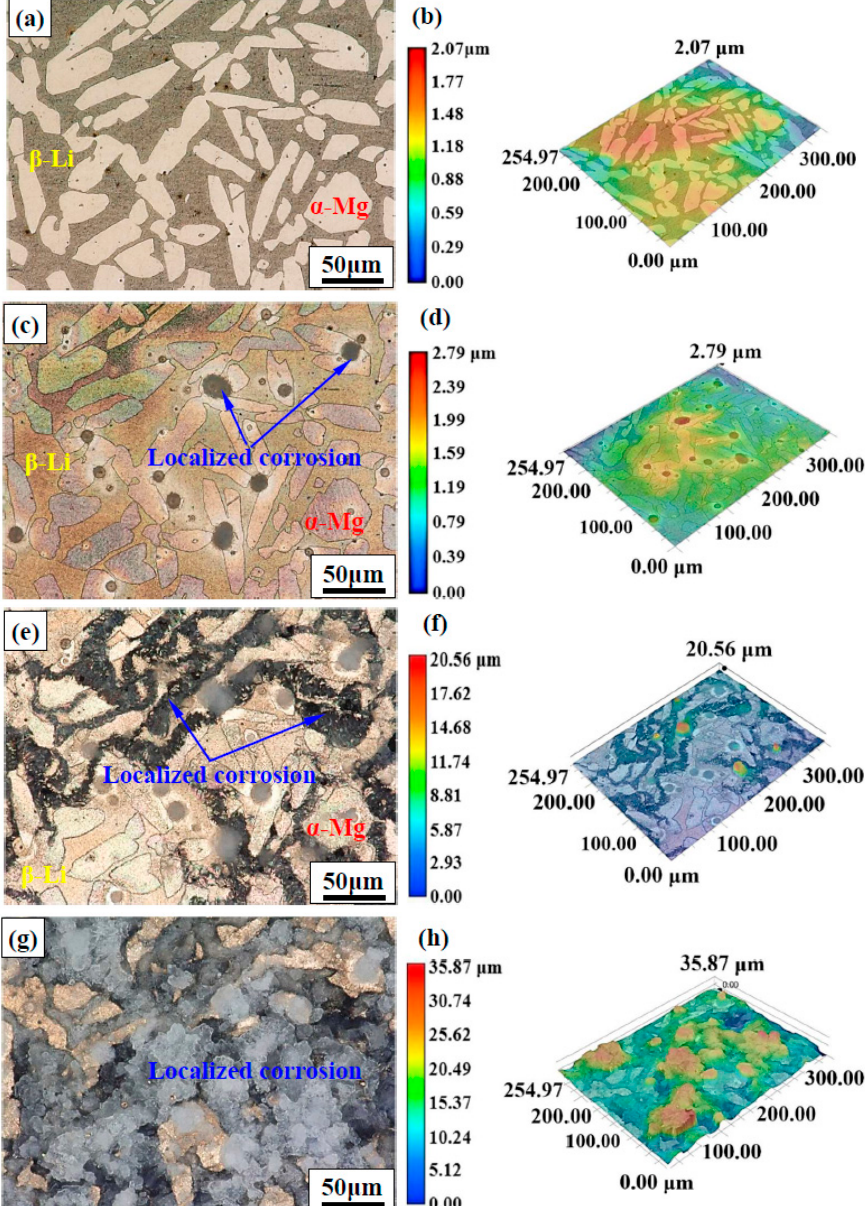
Figure 10. Surface corrosion morphologies and 3D images of the uncharged sample after being immersed in a 0.1 M NaCl solution for: ( a ) 0 h, ( c ) 2 h, ( e ) 4 h and ( g ) 8 h. Images ( b ), ( d ), ( f ) and ( h ) are the corresponding 3D morphologies of images ( a ), ( c ), ( e ) and ( g ), respectively.